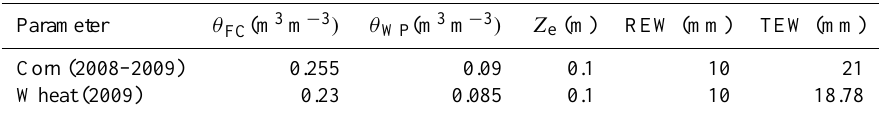
Table 2. Soil parameter values used for computing the water balance following the procedure described in Allen et al. (1998), being θ FC the soil water content at field capacity, θ WP the soil water content at wilting point, Z e the depth of soil surface evaporation layer, REW the readily evaporable water and TEW the total evaporable